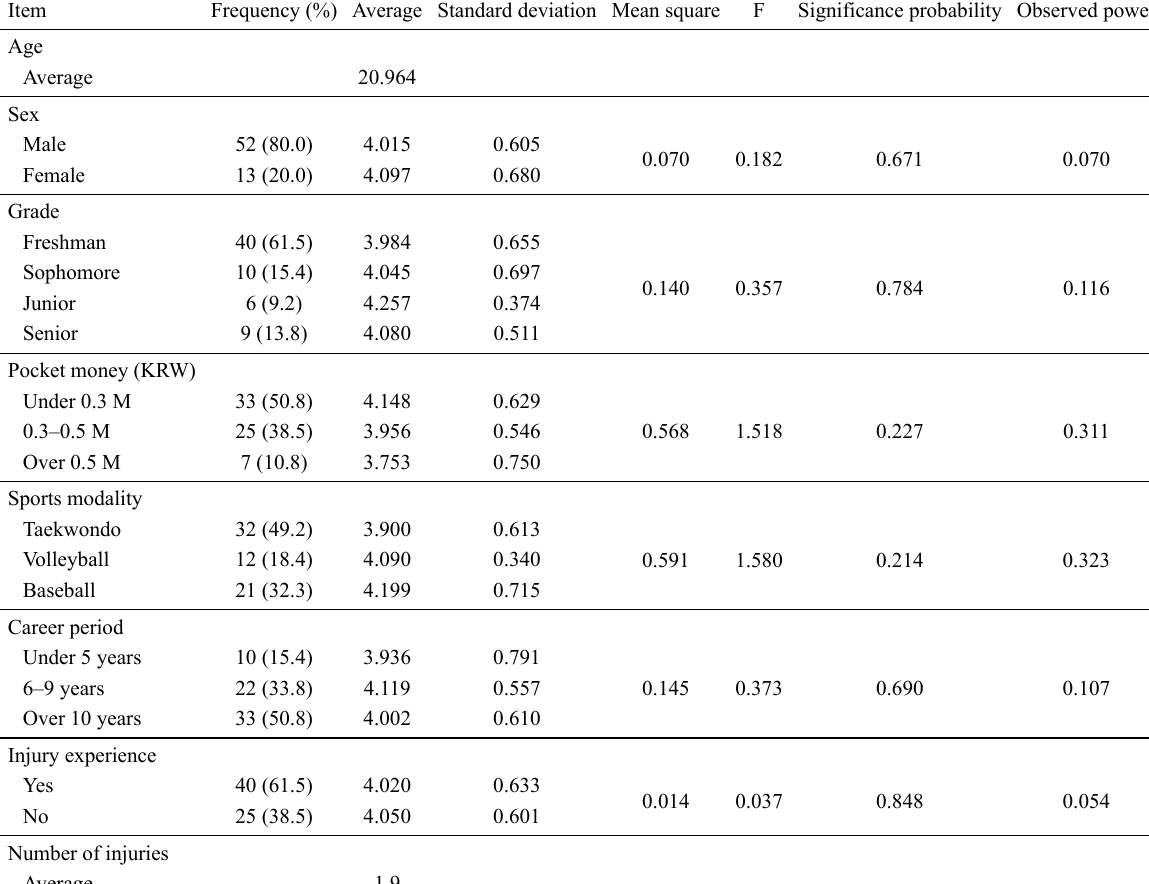
Table 2. Analysis of differences in demographic characteristics and preventive health behaviors.